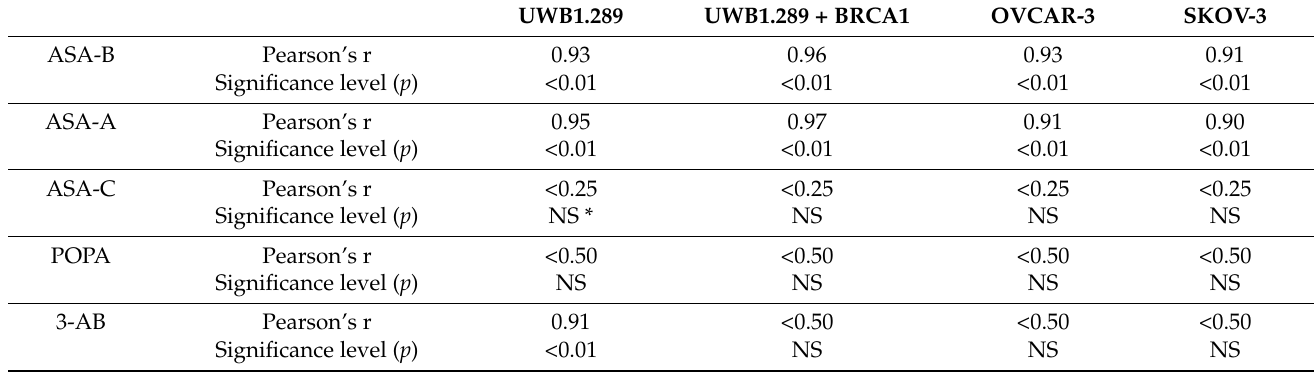
Figure 3. Correlation curves and 95% prediction bands between %PARP inhibition and %cytostatic effects in dose-response to the B,D-bilactam steroid alkylator ASA-B on UWB1.289 ( A ), UWB1.289+ BRCA1 ( B ), OVCAR-3 ( C ) and SKOV-3 ( D ) human ovarian cancer cells. Table 4. Pearson’s correlation indexes and respective statistical significance levels ( p ) of cytostatic effects and PARP inhibition induced by the homo-aza lactamic steroid alkylators ASA-B, ASA-A, ASA-C and the alkylating acid POPA, as well as 3-AB on UWB1.289, UWB1.289 + BRCA1, OVCAR-3 and SKOV-3 human ovarian cancer